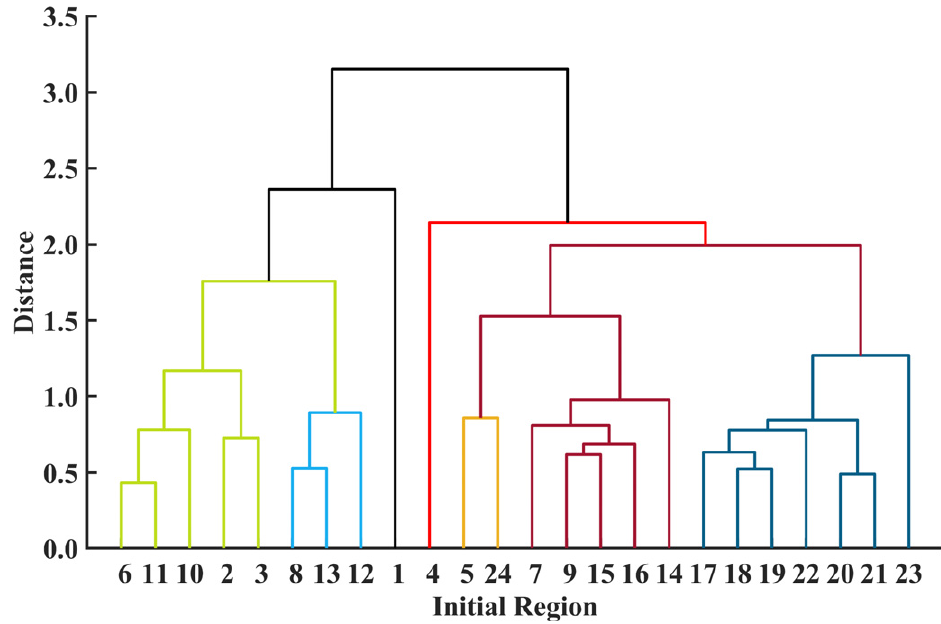
Figure 4. Hierarchical clustering results of regional divisions.